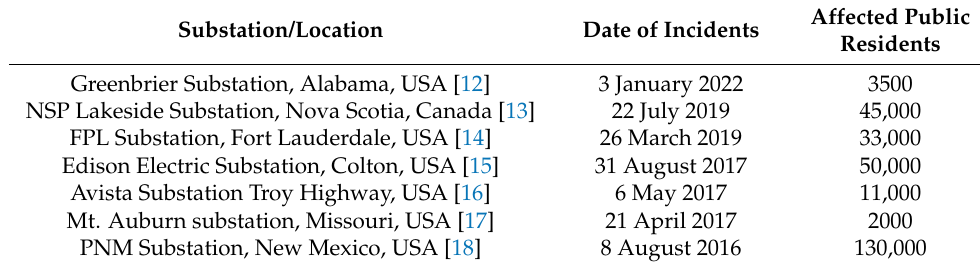
Table 1. Failure Cases due to Lightning Incidents.